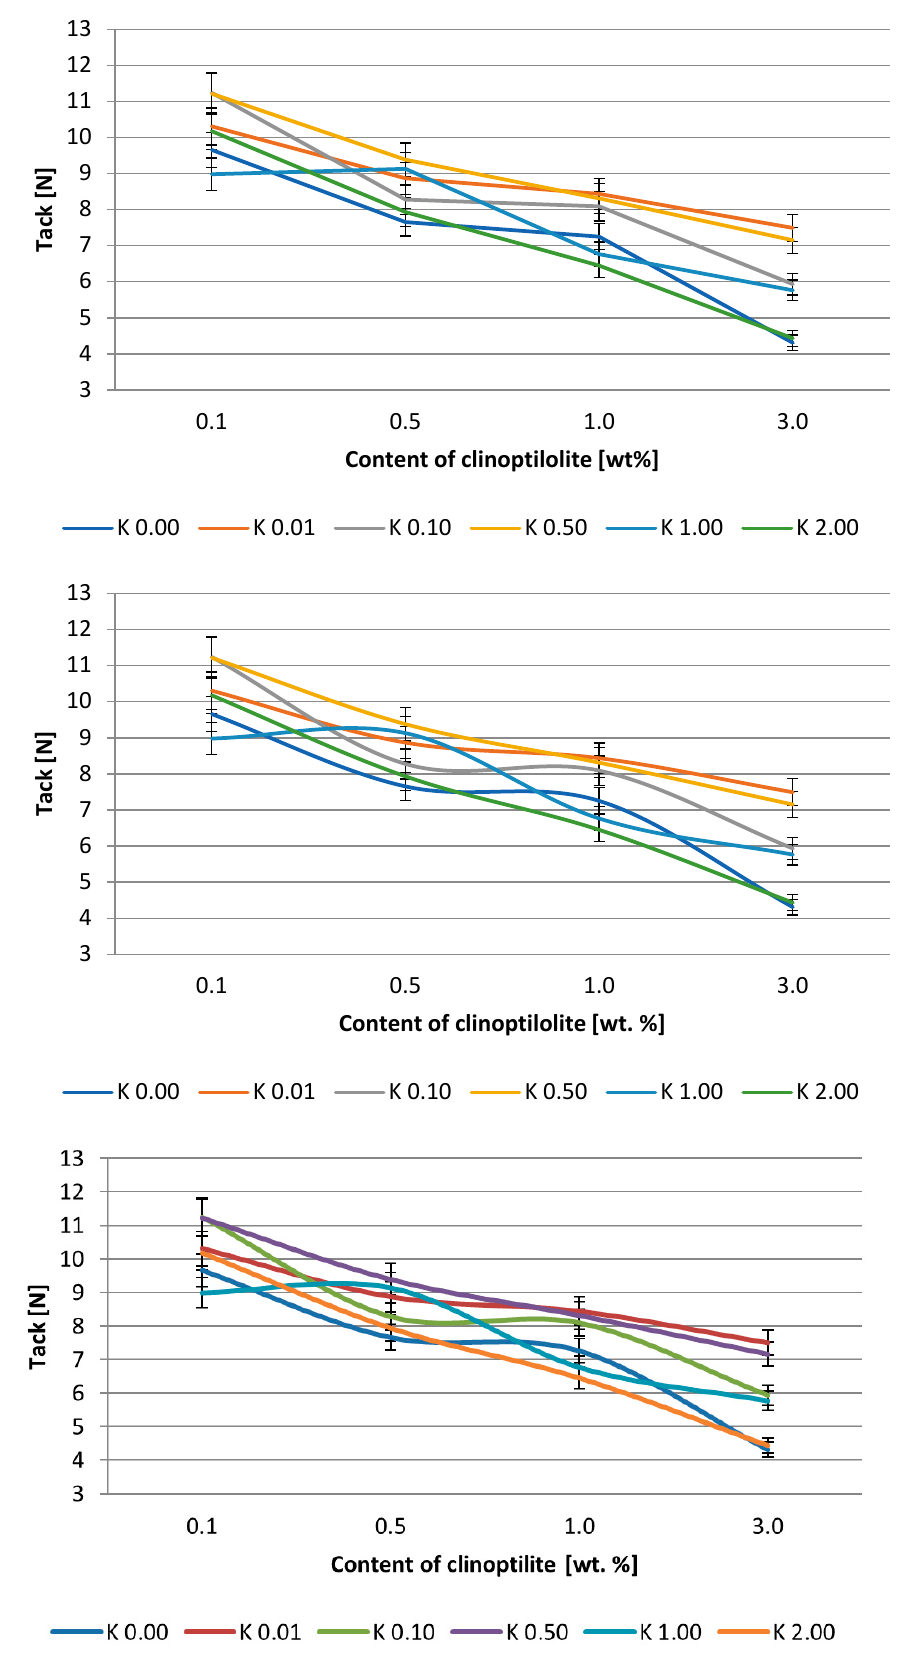
Figure 5. Effect of clinoptilolite content on the tack of silicone pressure-sensitive adhesives based on Q2-7358 resin.